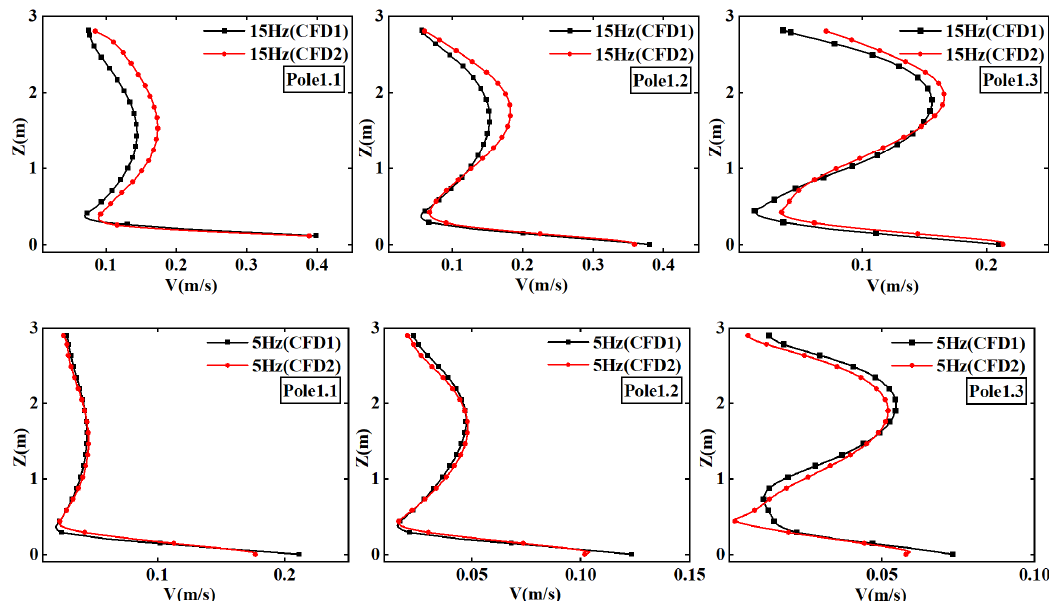
Figure 12. Calculated velocity profiles for SGD at three positions.